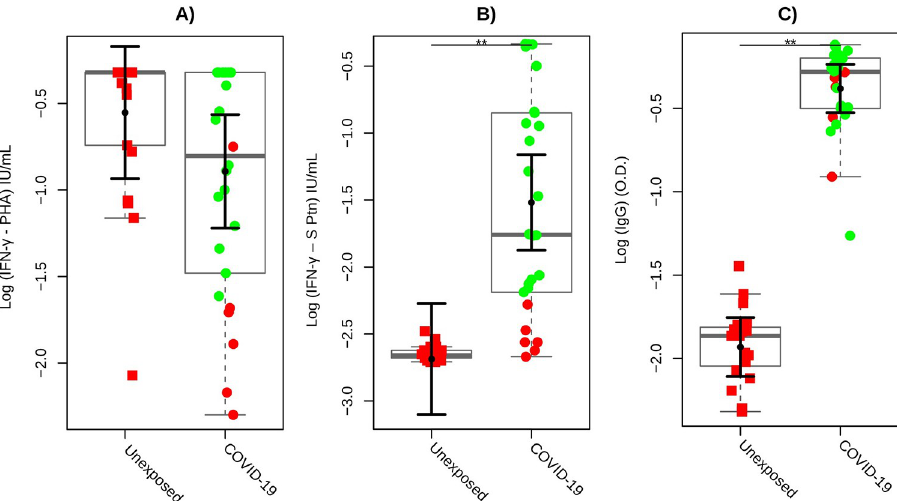
Fig 2. COVID-19 cellular response test. (A, B) Mean marginal IFN- γ production to assess cytokine production in response to PHA and SARS-CoV-2 S Protein, respectively, in whole blood COVID-19-cellular immunity test among the study population. (C) Anti-S protein IgG serology of healthy unexposed, and confirmed volunteers for COVID-19. Green circles indicate positive individuals (responders) for the cellular immune response, while red solid circles indicate those who were negative (non-responders). Solid squares represent individuals in the unexposed group, solid circles represent individuals in the COVID-19 group, and the box plots represent the interquartile range and the sample median (solid gray centerline). The larger black solid circles and central bars represent the fitted means estimated by the linear model, and the marginal mean values and their upper 95% confidence intervals were estimated for both unexposed individuals and for COVID-19 controlled for sex, BMI, and age for IFN- γ and PHA (mitogen) after stimulation with a specific biomarker for SARS-CoV-2 S protein. ** , P < 0.01.